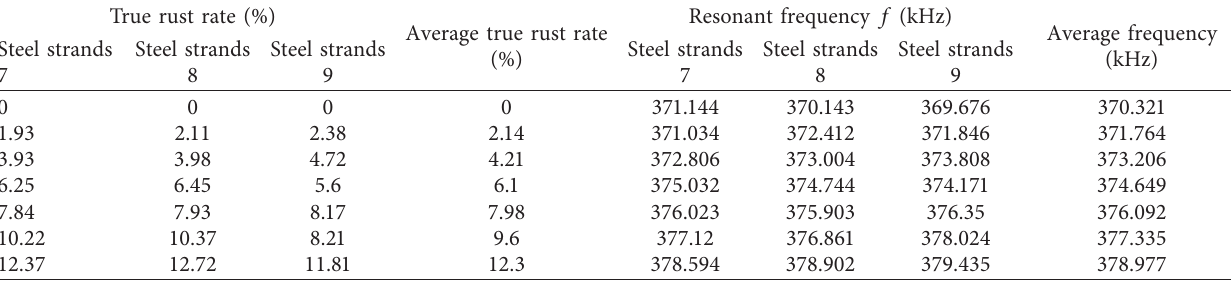
Table 5: Test data of the third group of steel strands.